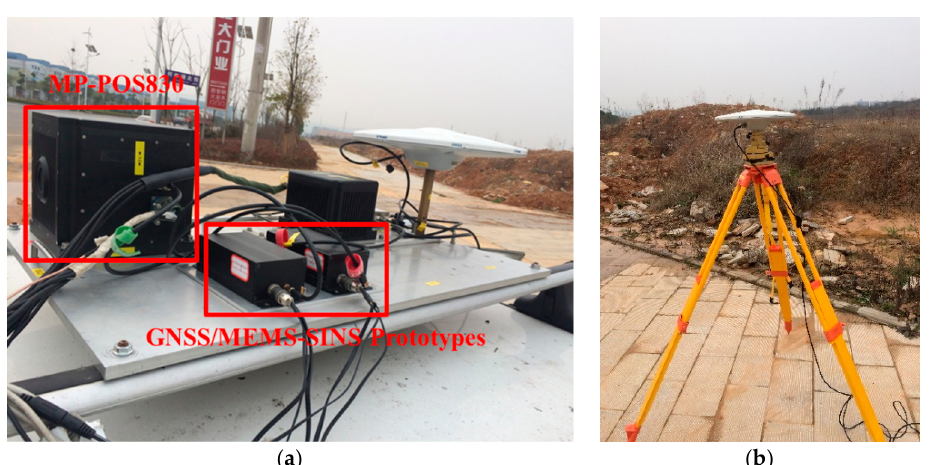
Figure 4. Test setup. ( a ) Equipment mounted on the roof of a car; ( b ) Base station. Table 1. STIM-300 Micro-Electro-Mechanical Systems (MEMS) specifications.